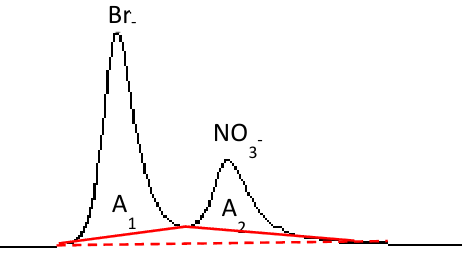
Figure 1. Integration carried out by considering two different baselines.